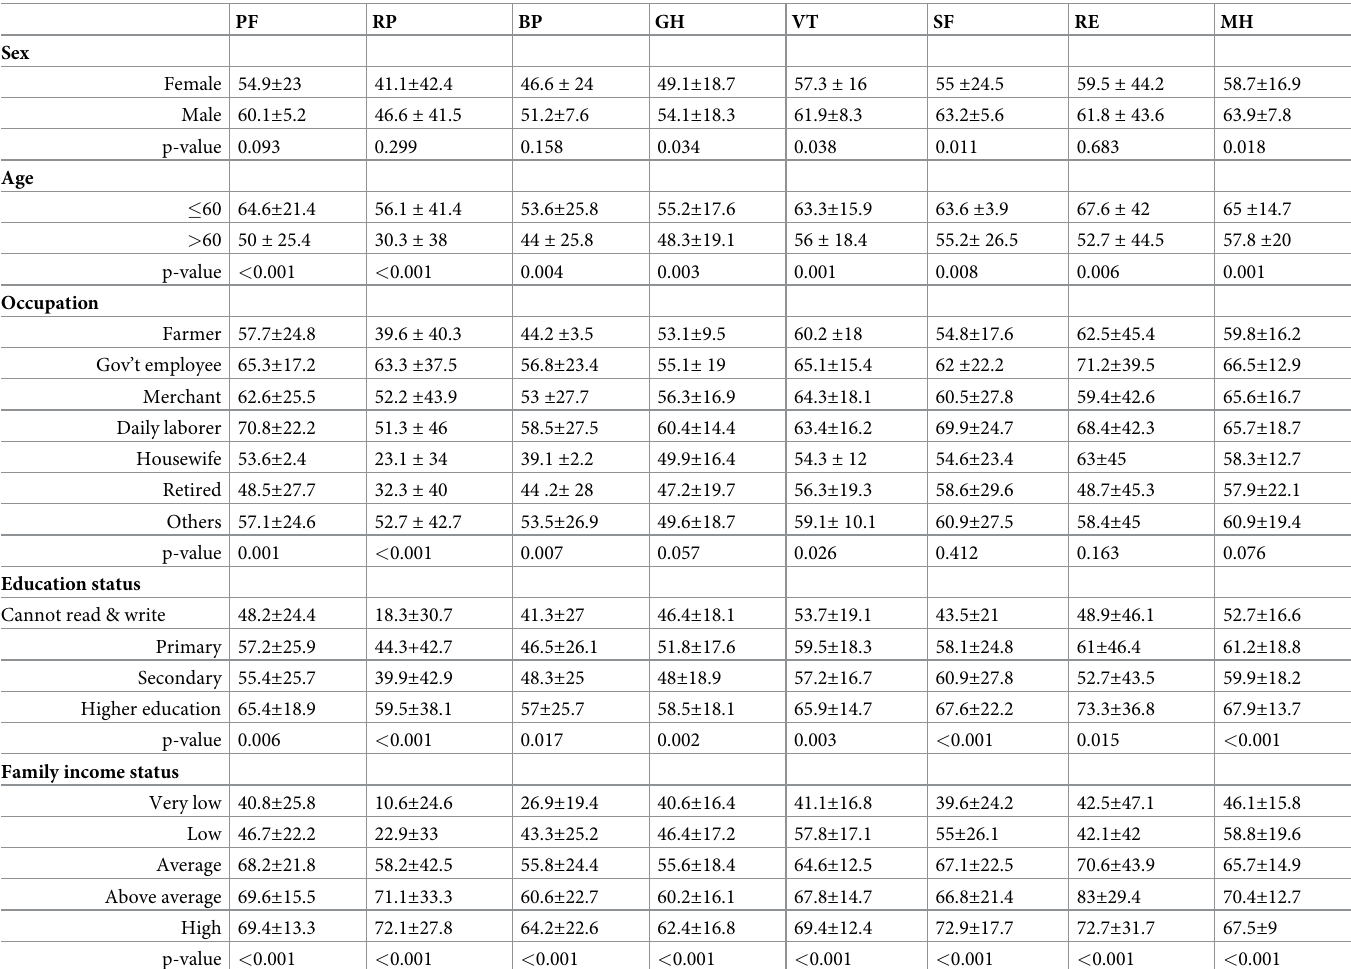
Table 4. Comparative statistical analysis of mean scores of SF-36 domains among patients with chronic kidney disease, according to the categorical socio-demo- graphic variables.